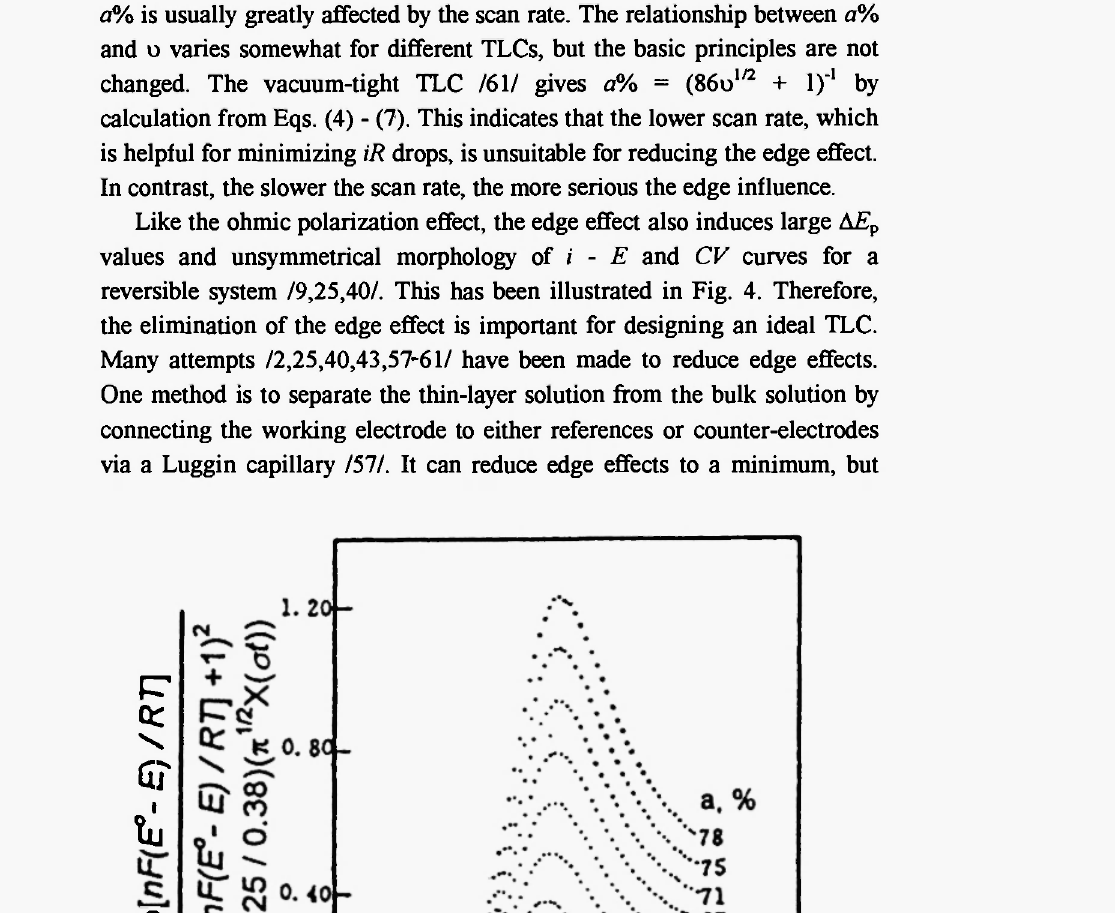
- 0 . 10 0.00 0.10 0.20 ( E °- £ ), V Fig. 4: Linear composition of current function for thin-layer electrolysis and:diffusion-controlled process, a represents the percent of diffusion current at £° : α=β/1+β) χ 100%; β represents the ratio of diffusion and electrolysis current at E°'. (From Ref.